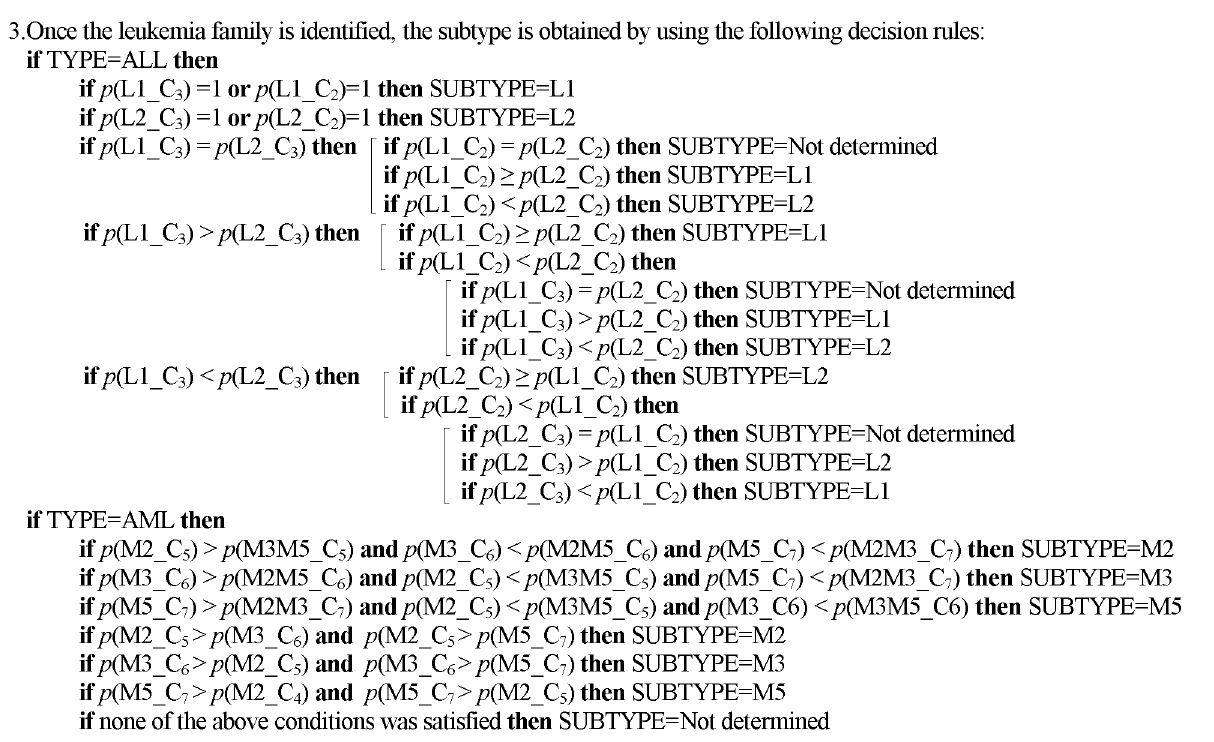
Fig 14. Diagnosis algorithm of types and subtypes of